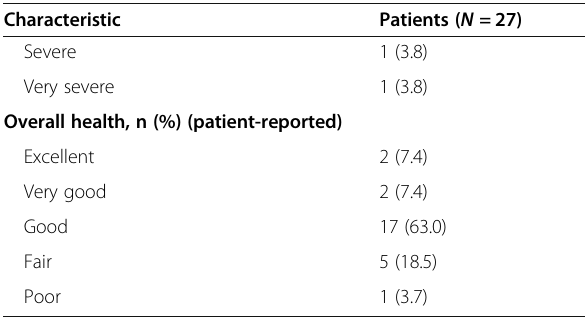
Table 2 Demographic and clinical characteristics of concept elicitation patient interviewees